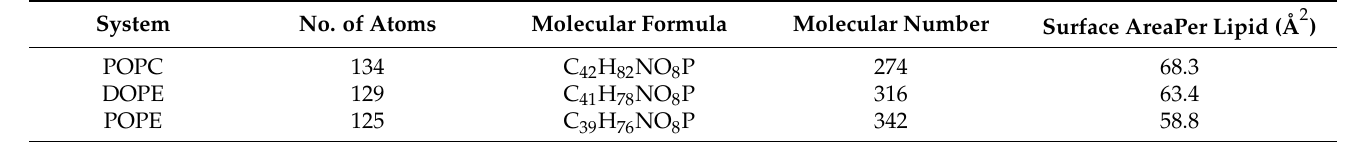
Table 1. Simulation details of the phospholipid